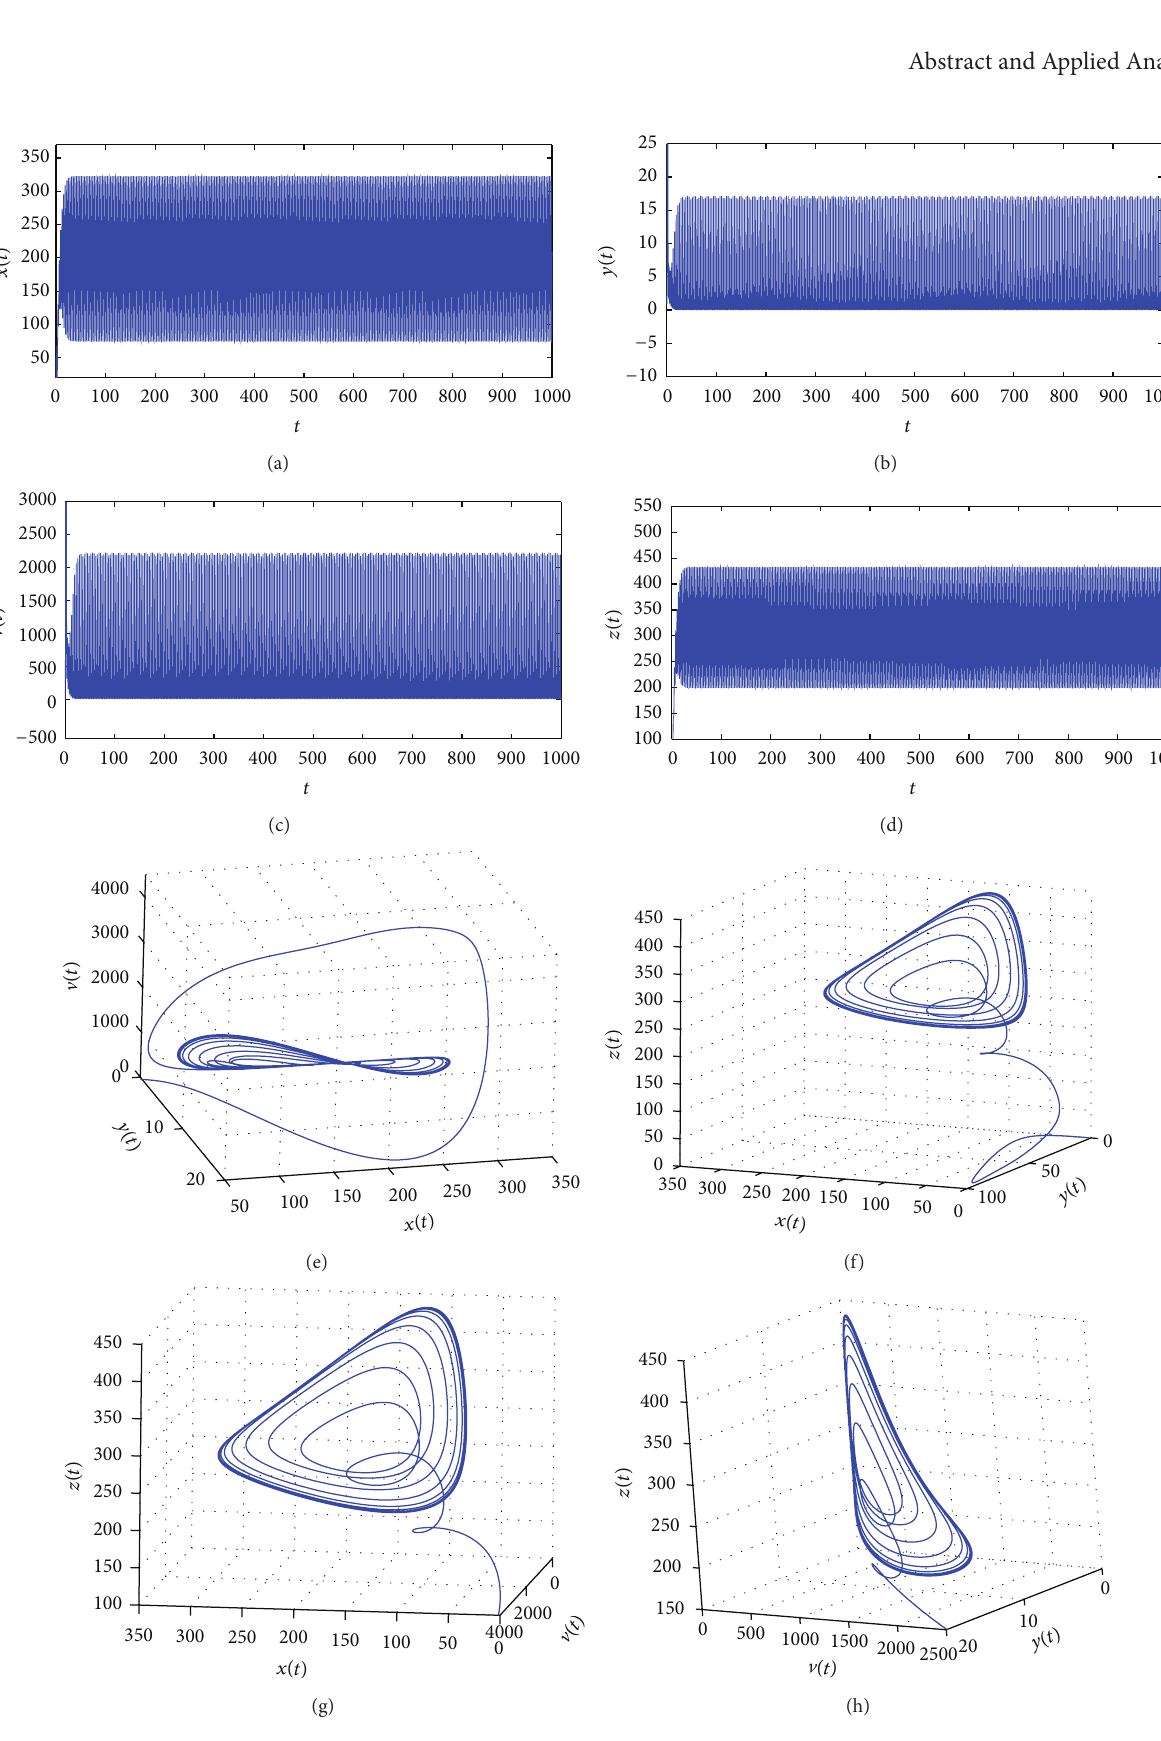
Figure 2: The time histories and the phase trajectories of the system (50) when Hopf bifurcation occurs for 𝜏 2 = 0.57